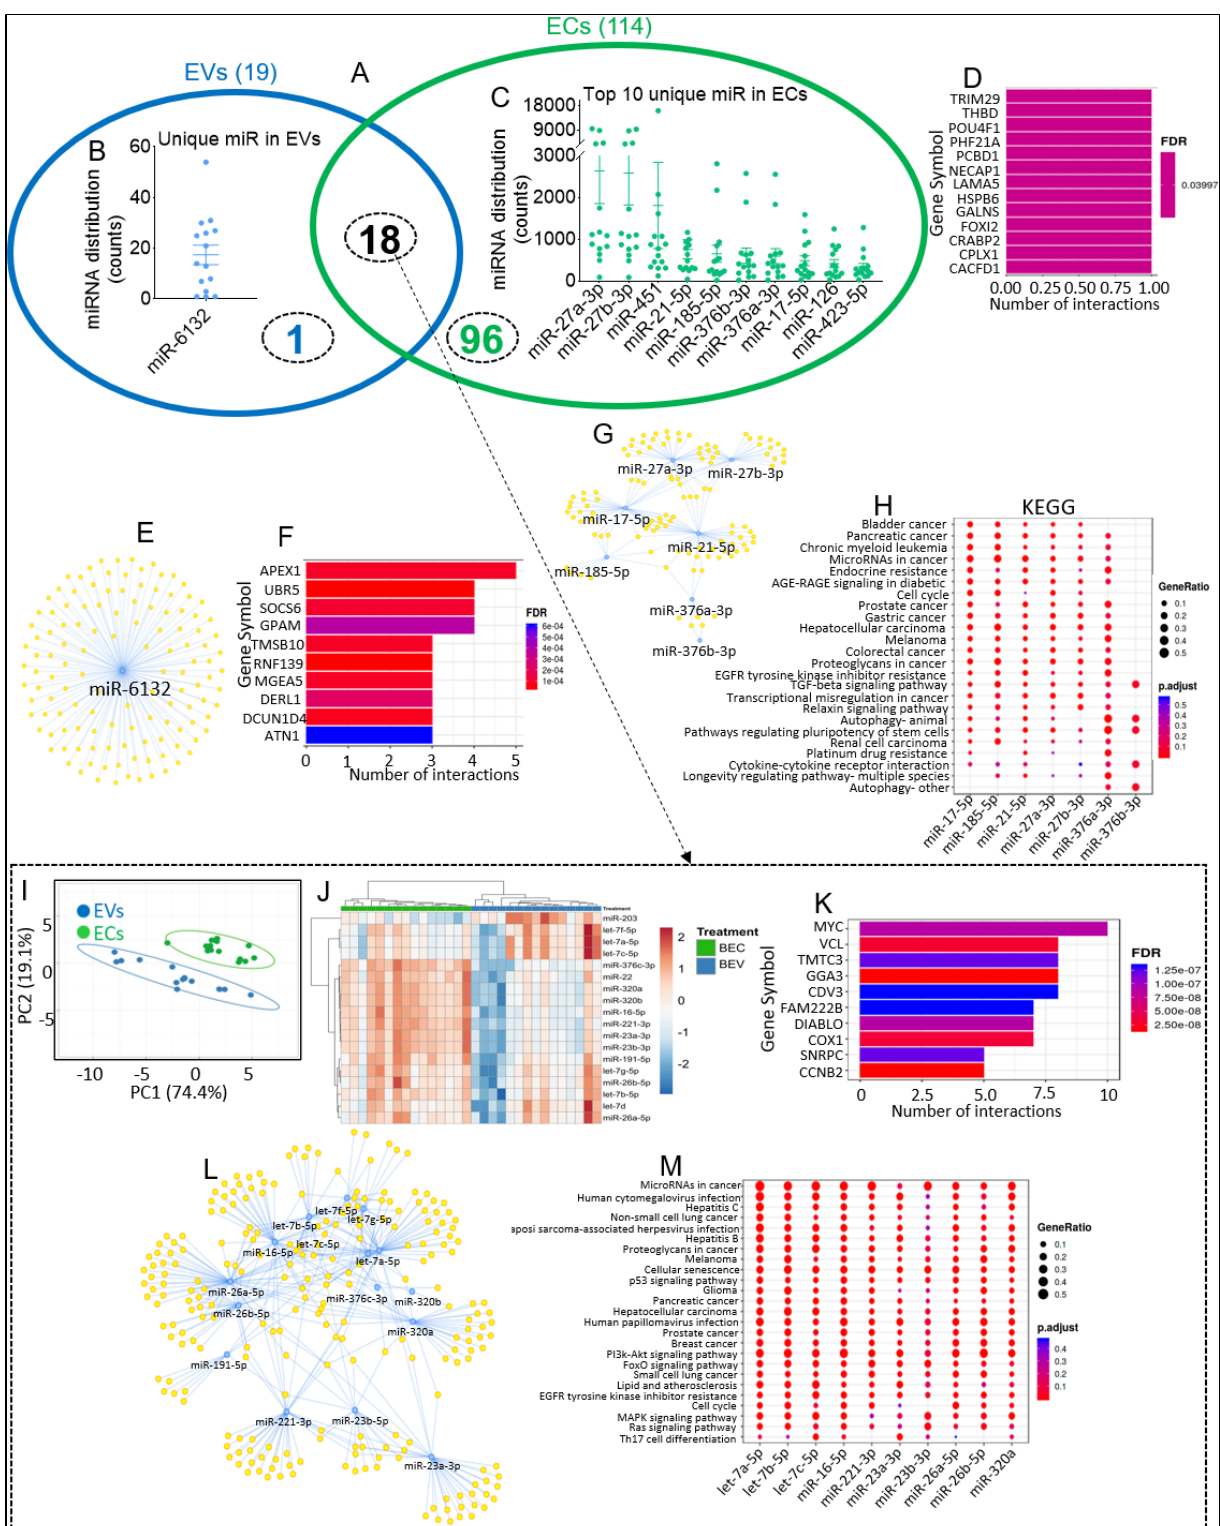
Figure 4. Identification and pathway analysis of common and unique miRNAs associated with EVs and ECs. ( A ) Venn diagram showing common and unique miRNAs among the common EV and EC miRNAs ( n = 15). ( B ) miRNA distribution counts of EV‑associated unique miRNAs (1) for n = 15 RMs. ( C ) miRNA distribution counts of top 10 EC‑associated miRNAs. ( D ) miRNA‑target enrichment analysis showing top target genes by number of interactions for the 1 unique EV‑associated